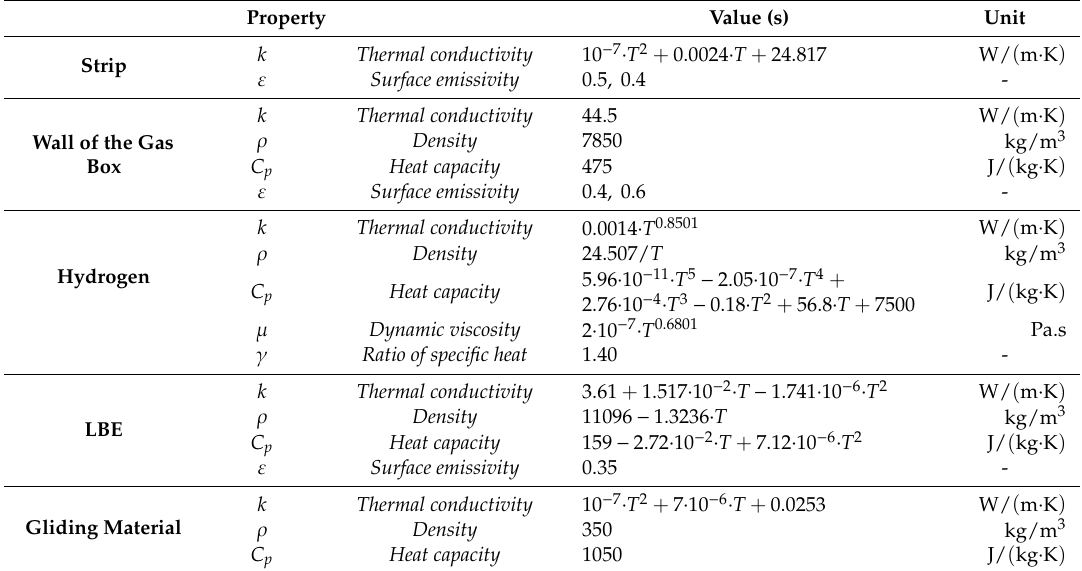
Table 2. Physical properties of each